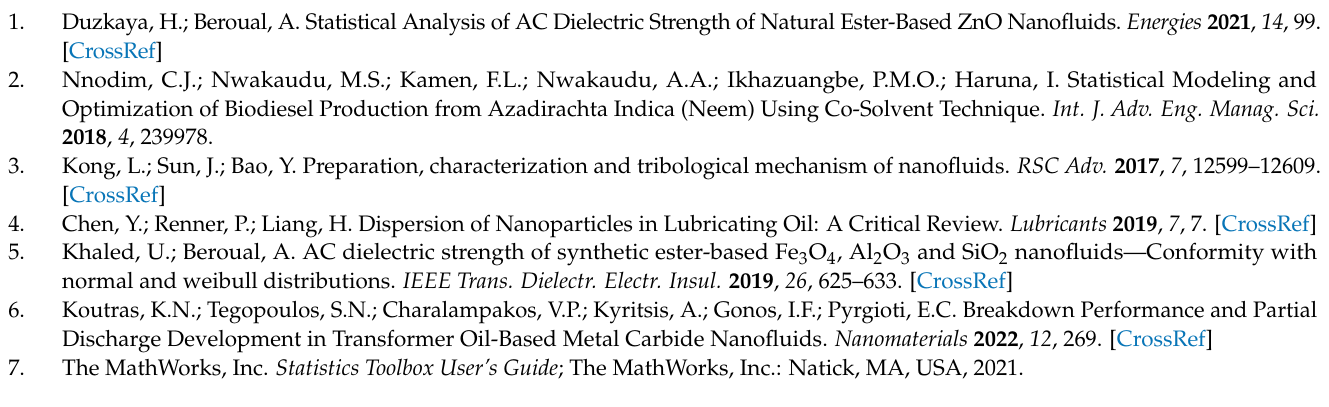
Figure 26. ROKwinol80 samples after conducting breakdown voltage tests. S7— ROKwinol80 ≈ 1%, Figure 26. ROKwino l80 samples after conducting breakdown voltage tests. S7—ROKwino l80 ≈ 1%, S9— ROKwinol80 ≈ 2%, S11— ROKwinol80 ≈ 3%. S9—ROKwino l80 ≈ 2%, S11—ROKwino l80 ≈